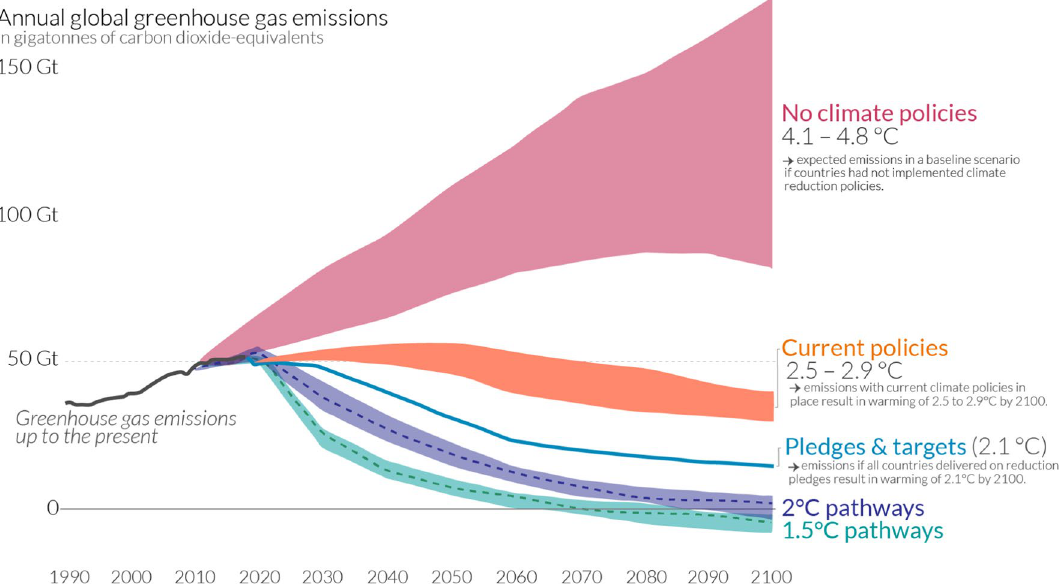
Fig. 23 Global GHG emission and warming scenarios under various policies